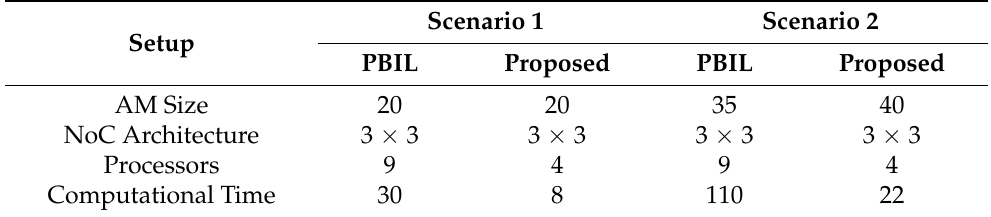
Table 2. Computational time (s) of existing and proposed metascheduling